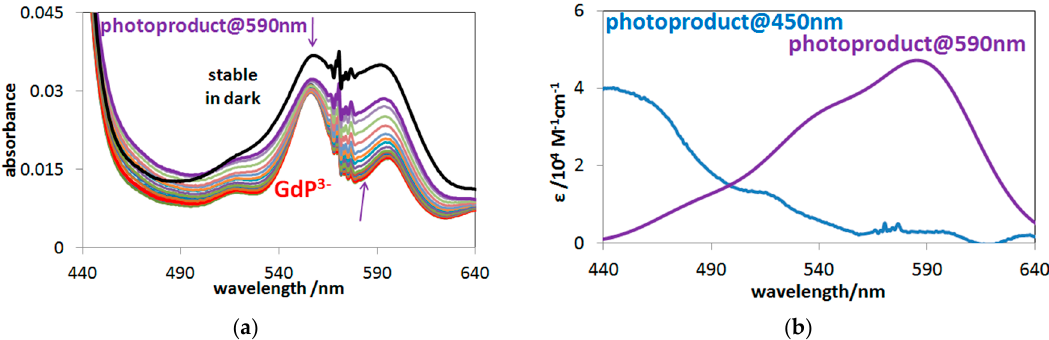
Figure 7. ( a ) Spectral changes during the 45-min photolysis at the Q-maximum (555 nm). ( b ) Molar absorption spectra of the photoproducts.